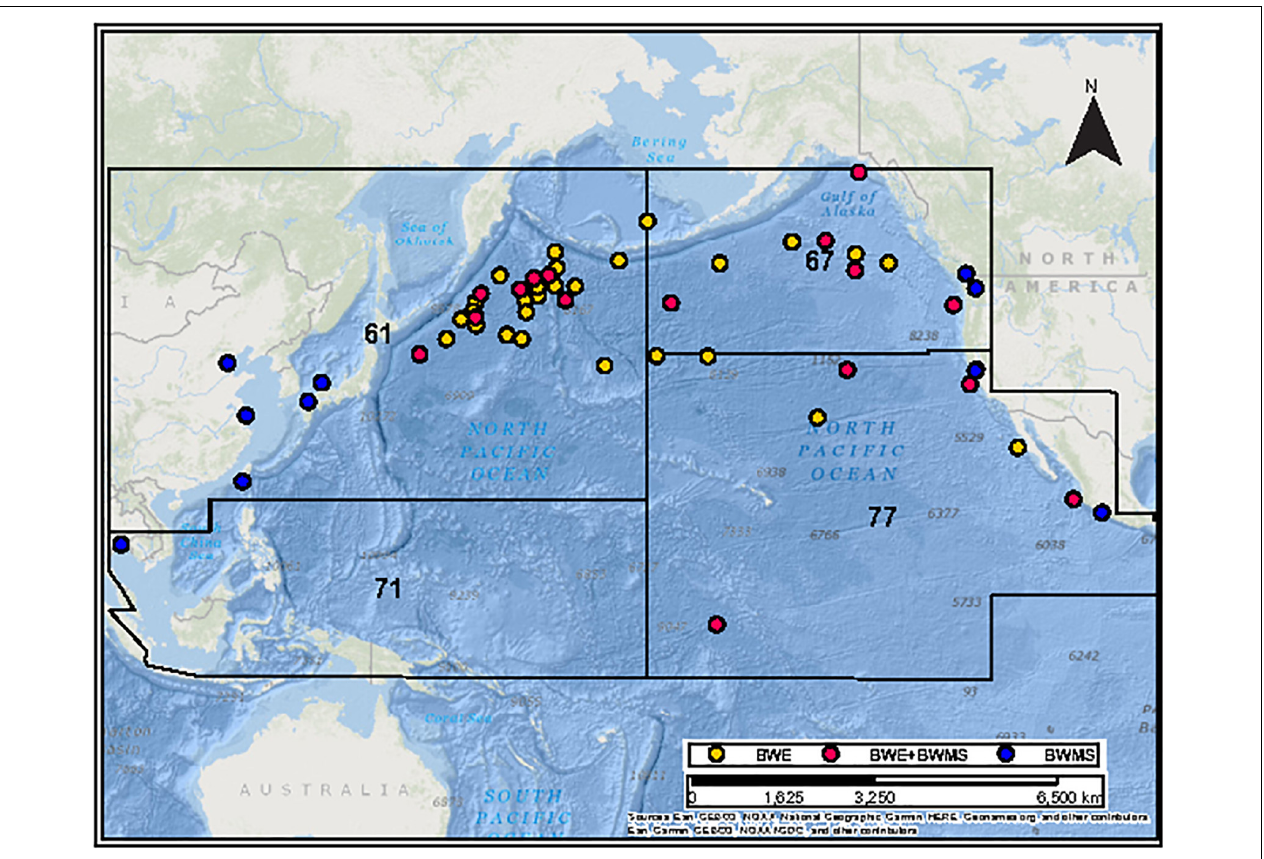
FIGURE 1 | Map showing the location of most recent ballast uptake by ships using different ballast water management strategies: yellow dots denote ships performing ballast water exchange (BWE), red dots denote ships performing BWE + ballast water management system (BWMS) and blue dots denote ships using exclusively BWMS. Numbers denote major fisheries regions of the Food and Agriculture Organization of the United Nations: 61 – Pacific Northwest; 67 – Pacific Northeast; 71 – Pacific Western Central; 77 – Pacific Eastern